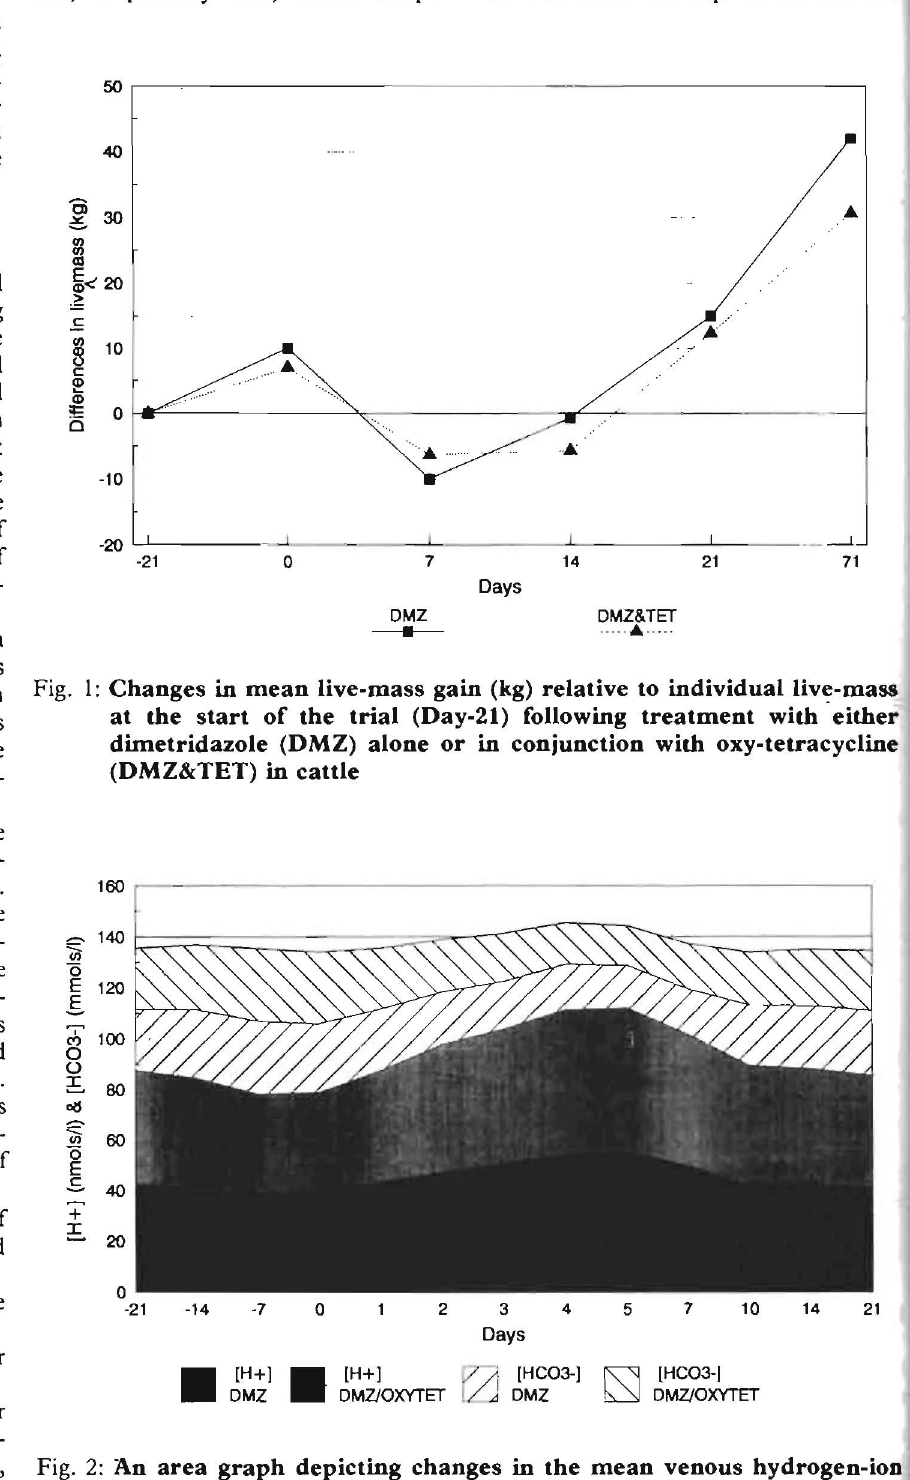
Fig. 2: An area graph depicting changes in the mean venous hydrogen-ion (shaded areas) and bicarbonate-ion (hatched areas) concentrations before and after treatment with either dimetridazole (DMZ) alone or in conjunction with oxytetracycline (DMZ&OXYTET) in